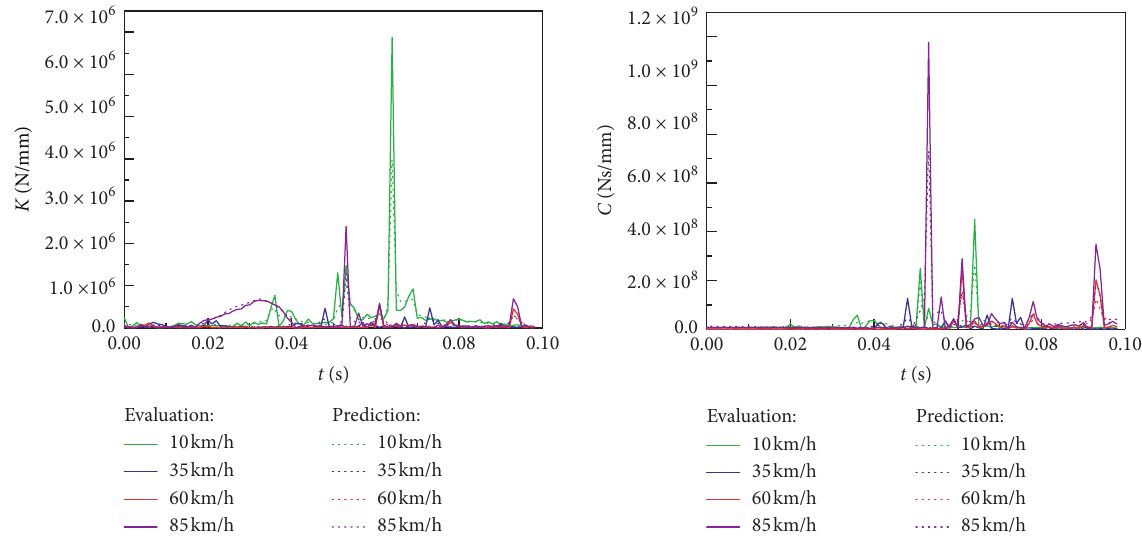
Figure 6: Anticlimbing device comparisons of estimation and